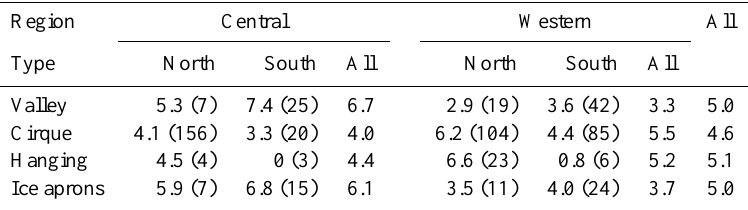
Table 3. Area loss (%) according to glacier type in the central and western MCR. Number of glaciers of each type is given in parentheses. The two compound-valley glaciers located on the southern slope of the central MCR are not included (see